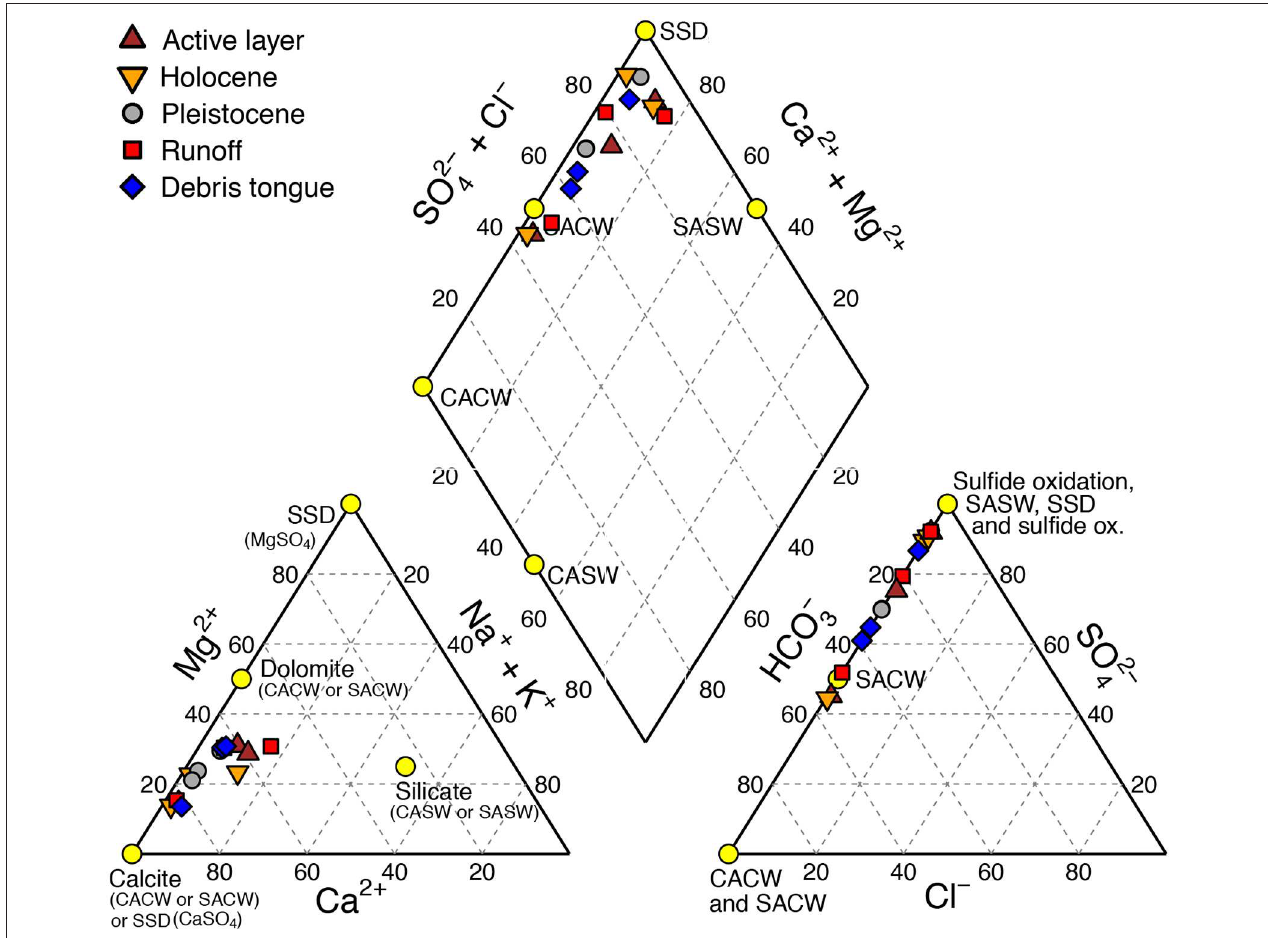
FIGURE 4 | Piper diagram showing the chemical composition of MilliQ water treated with five different retrogressive thaw slump sediments (see legend) exposed to varying degrees of prior thaw. The composition of each point reflects the relative concentrations (in meq L − 1 ) of major cations (left), anions (right), and both together (center) as a percent. See details in main text for calculation of end-members: CACW, H 2 CO 3 carbonate weathering; SACW, H 2 SO 4 carbonate weathering; CASW, H 2 CO 3 silicate weathering; SASW, H 2 SO 4 silicate weathering; SSD, sulfate salt (gypsum)